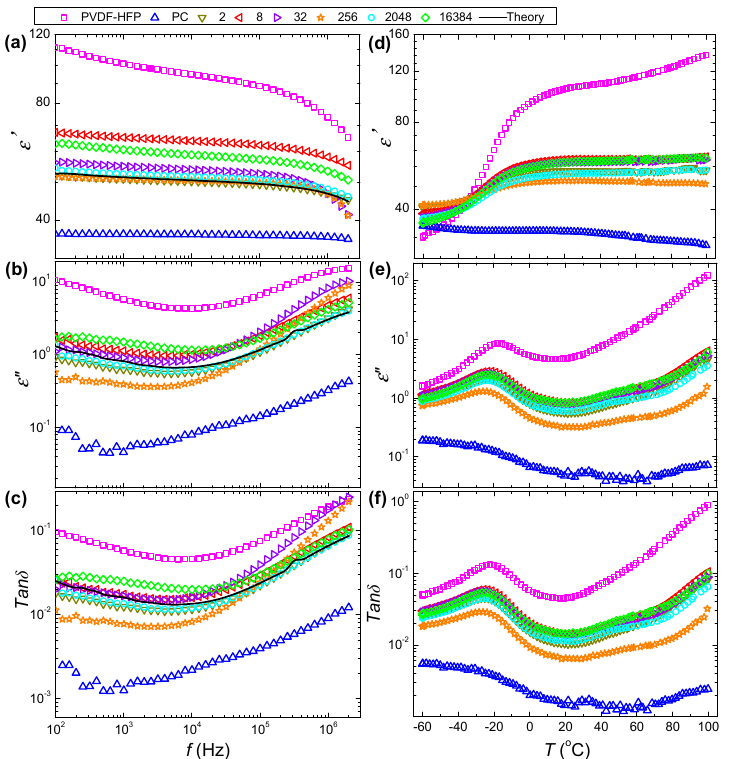
Figure 6. ( a ) Storage permittivity, ( b ) loss permittivity, and ( c ) loss tangent spectra versus frequency at 30 °C for PVDF-HFP/PC films. ( d – f ) Temperature dependent dielectric spectra measured at 1 kHz. Solid lines in ( a – c ) are theoretical predictions for layered dielectrics without interphase layers.